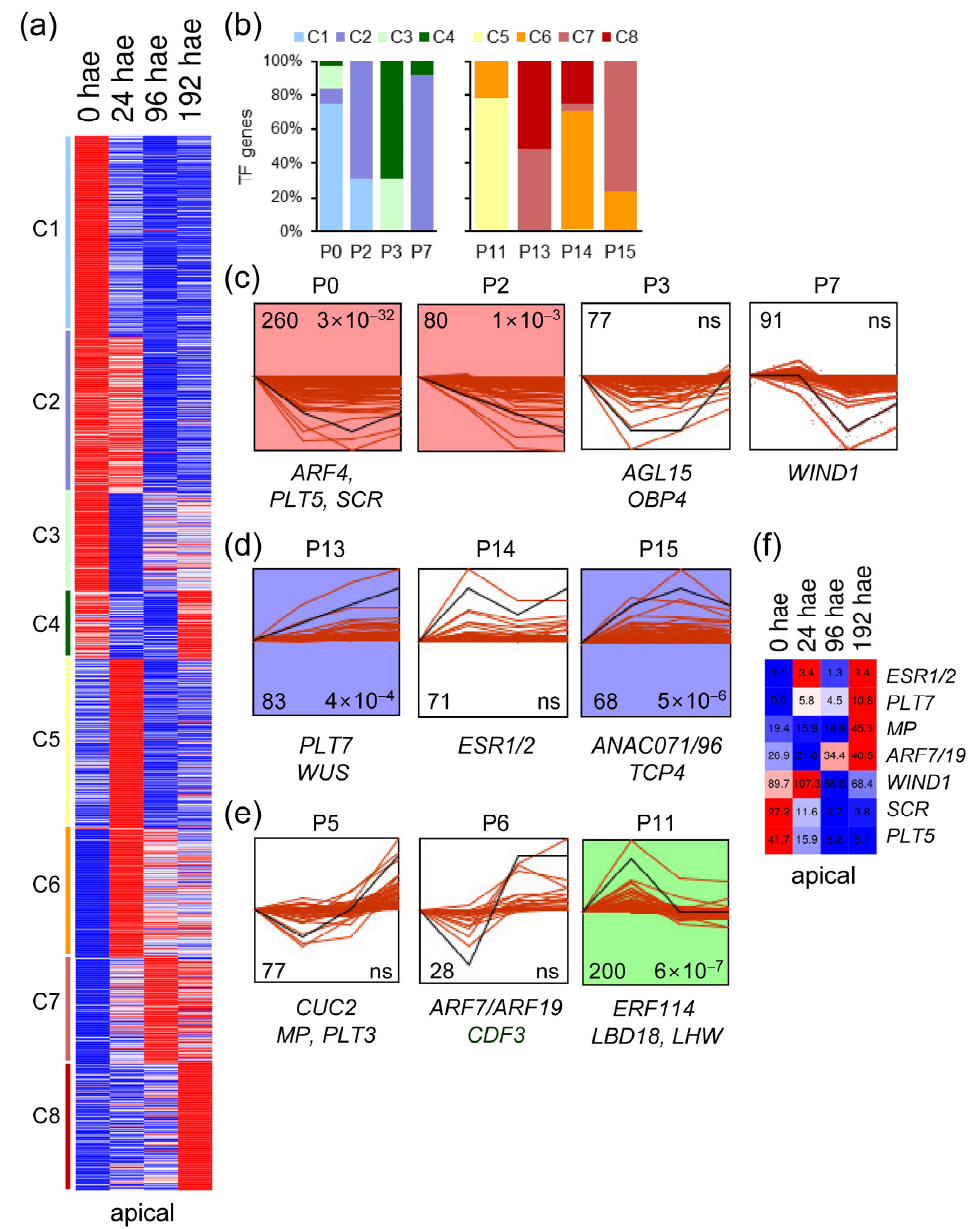
Figure 2. Expression profiles of TF genes during de novo shoot formation. ( a ) K-means analysis of the different TFs expressed in the apical region of the hypocotyl over time. ( b ) Percentage of k-means clusters associated with each expression profile. ( c – e ) Selected expression profiles of downregulated TF genes identified in STEM. Some TFs whose A. thaliana orthologs are known to be involved in regeneration are indicated. The numbers in the left corner indicate the number of TF genes in each expression profile, and the numbers in the right corner indicate the p value; ns: not significant p value. ( f ) Heatmap of selected TF genes with differential expression in the apical region of the hypocotyl. Blue/white/red in ( a , f ) indicate normalized cpm values in each row, where red indicates the highest abundance of transcripts. Gene annotations are found in Table S1.